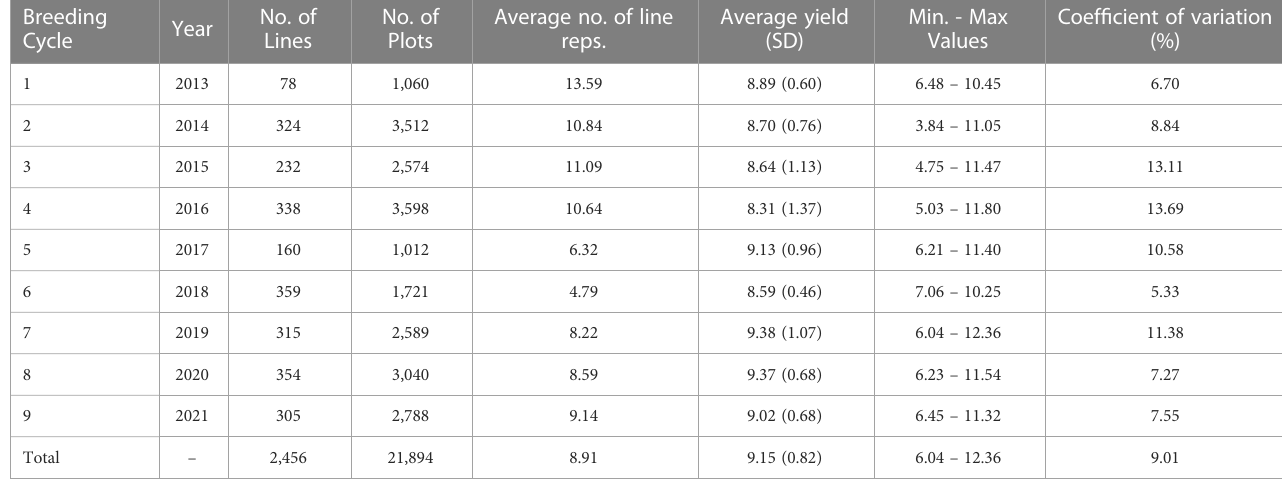
TABLE 1 Descriptive statistics for the grain yield (kg grain/8.25m 2 ) of F 6 wheat breeding lines. Breeding